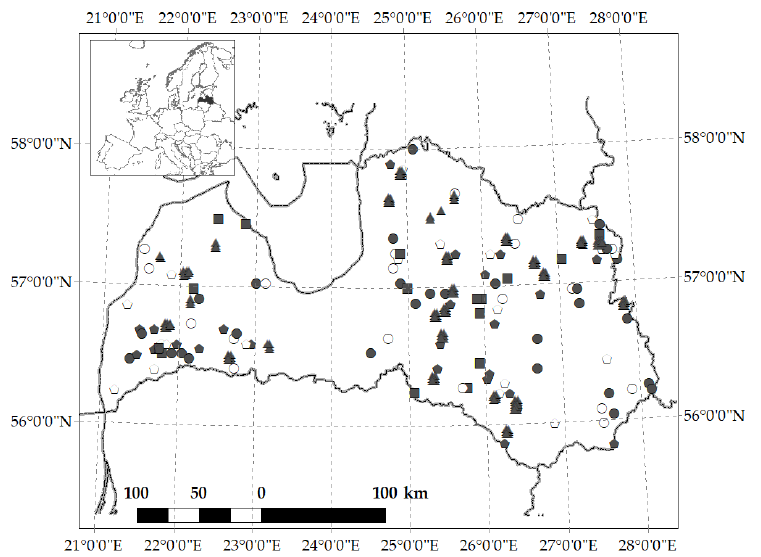
Figure 1. Distribution of sample plots in mature ( • , 41–60 years) moderately overmature ( ⬟ , 61–80 years), overmature ( ■ , 81–100 years), and old-growth ( ▲ , 101–140 years) European aspen ( Populus tremula L.) stands, with dark symbols indicating unmanaged stands in all age groups, and clear circles ( ○ ) and pentagons ( ) indicating managed mature and moderately overmature stands.